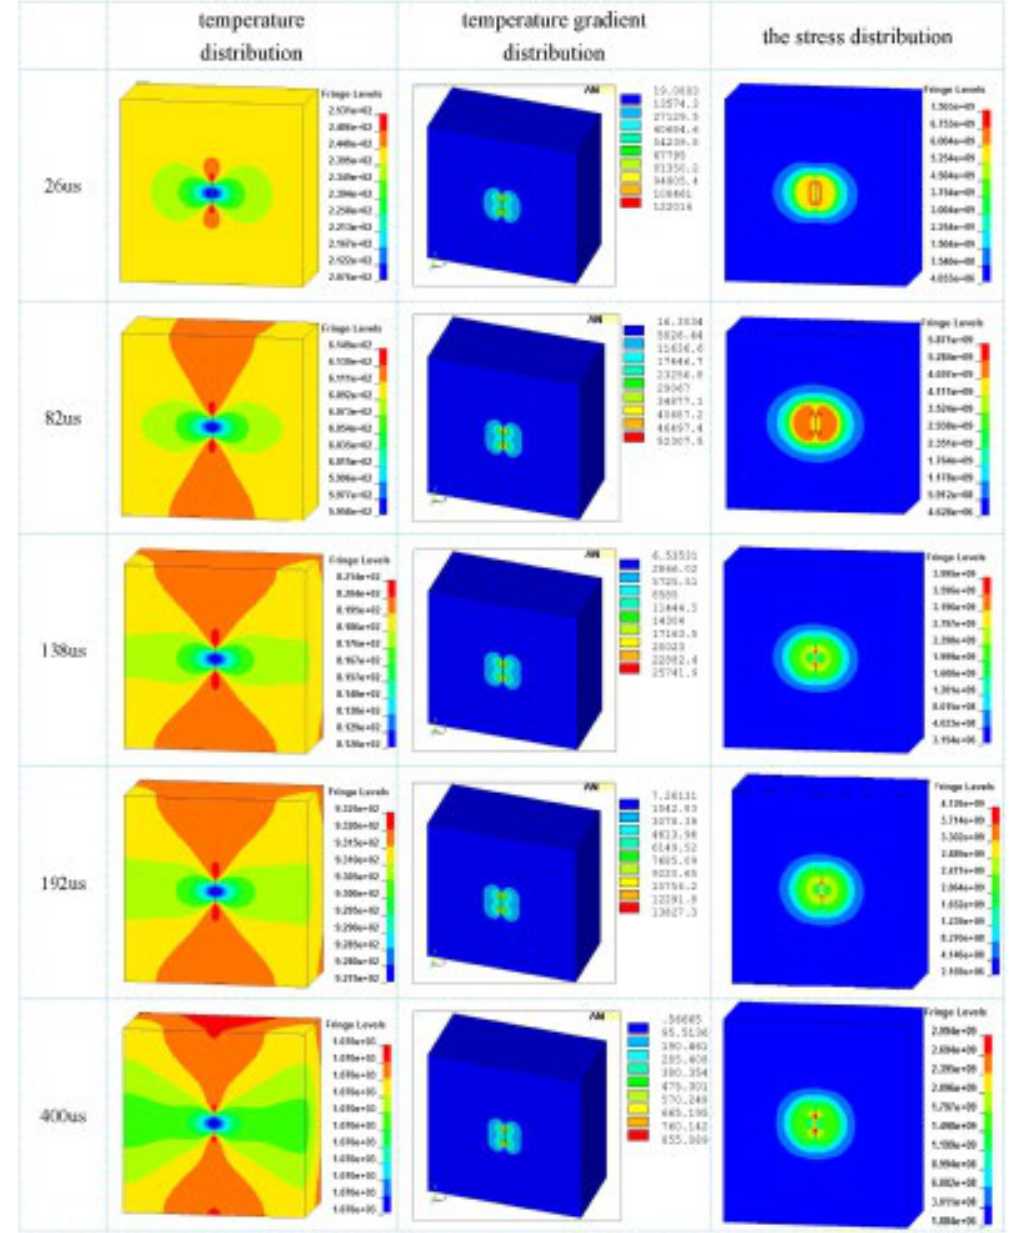
Figure 2. The time evolution of localized temperature field, temperature gradient and Von mises stress (the unit of the quantities in the Figure is system of electromagnetic